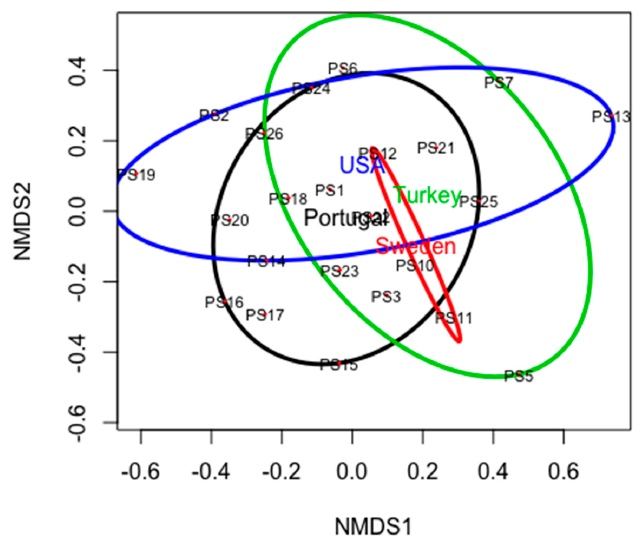
Figure 4. Two-dimensional non-metric multidimensional scaling (NMDS) biplots based on Bray–Curtis distances displaying di ff erences among the fungal community structures identified to the species level. The points represent Pinus samples (see sample ID, Table 1). The coloured ellipses represent the country of the samples’ origin. R 2 = 0.95.